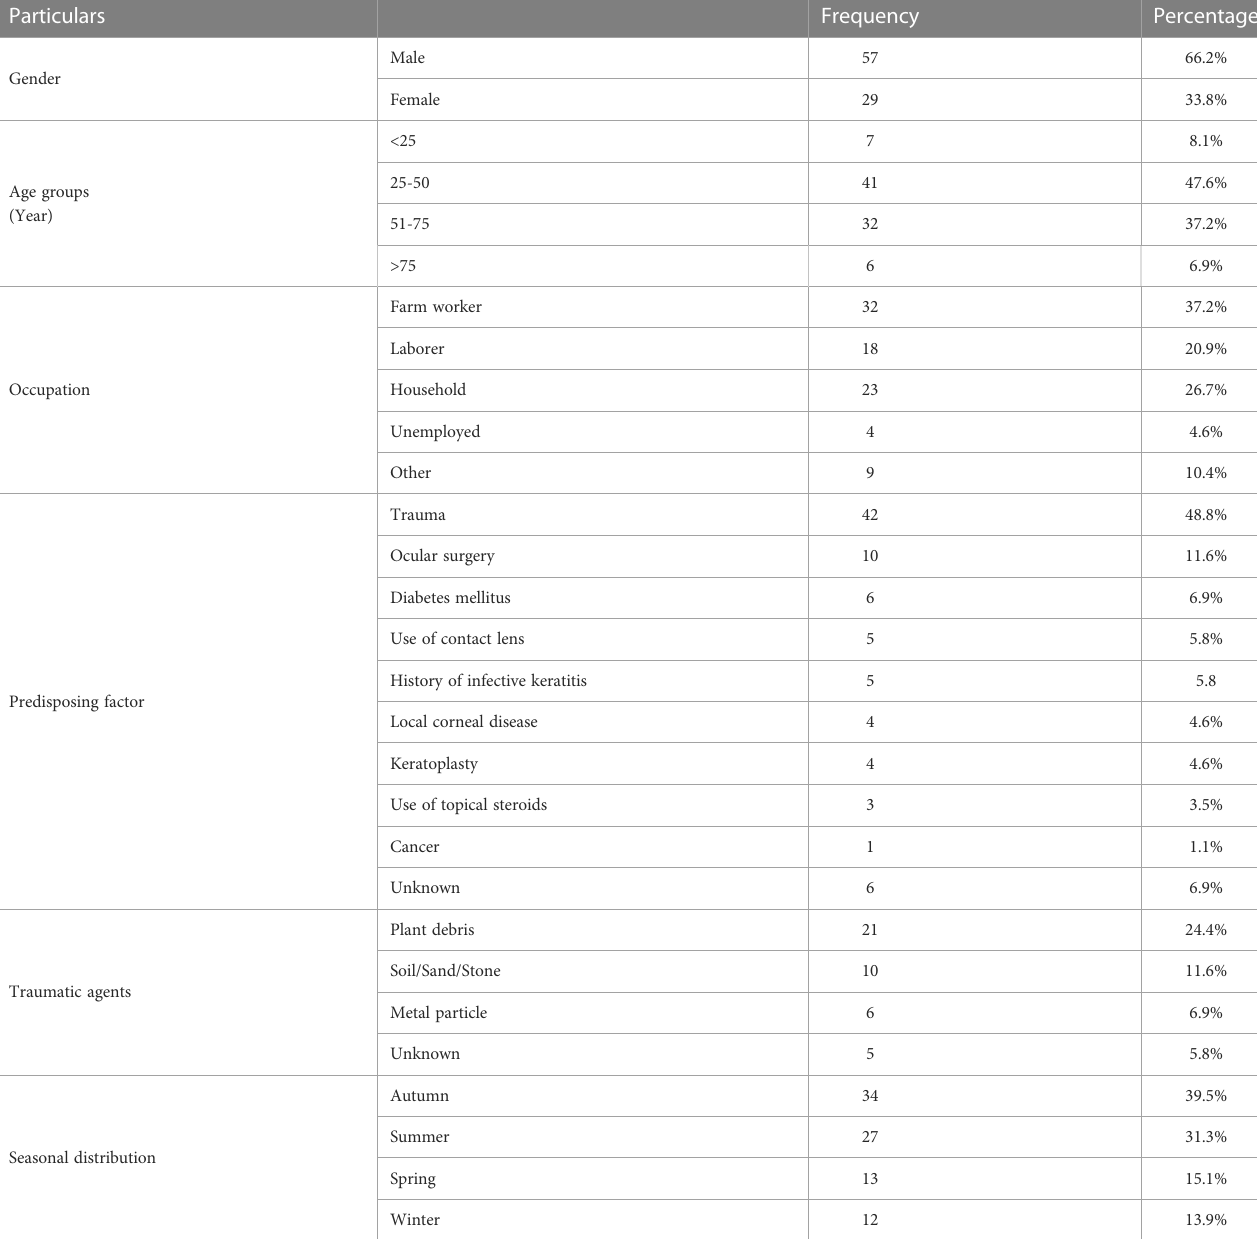
TABLE 1 Demographic characteristics, predisposing factors and traumatic agents in patients with fungal keratitis.